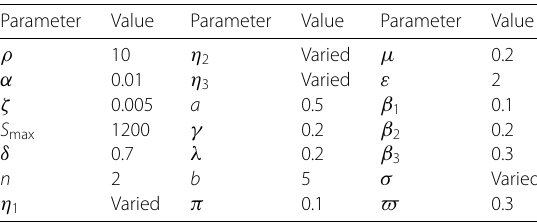
Table 2 Some values of the parameters of model (28) Parameter Value Parameter Value Parameter Value ρ 10 η 2 Varied μ 0.2 α 0.01 η 3 Varied ε 2 ζ 0.005 a 0.5 β 1 0.1 S max 1200 γ 0.2 β 2 0.2 δ 0.7 λ 0.2 β 3 0.3 n 2 b 5 σ Varied η 1 Varied π 0.1 (cid:22)